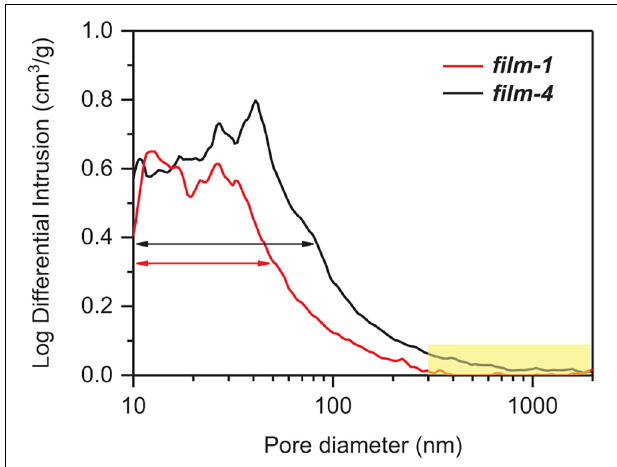
FIGURE 4 | Pore-size distribution of films 1 (red) and 4 (black) measured by mercury porosimetery.